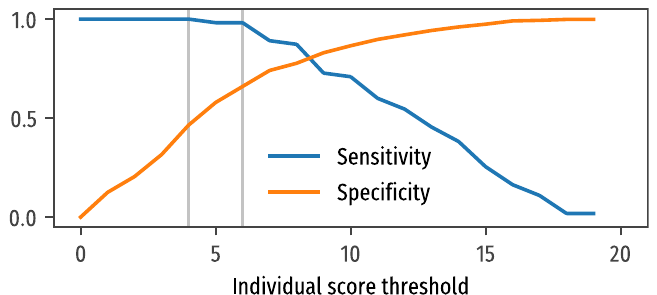
Figure 6. Expected sensitivity and specificity if the threshold to refer subjects to lab is changed to a different value. The vertical lines correspond to a threshold of 4 and 6. A threshold of 4 is maybe too conservative; in other contests, one can safely use